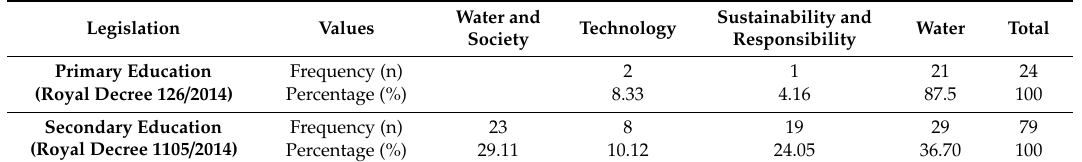
Table 7. Number of times (n) and percentage (%) that primary and secondary and baccalaureate educational regulation mention water in each category